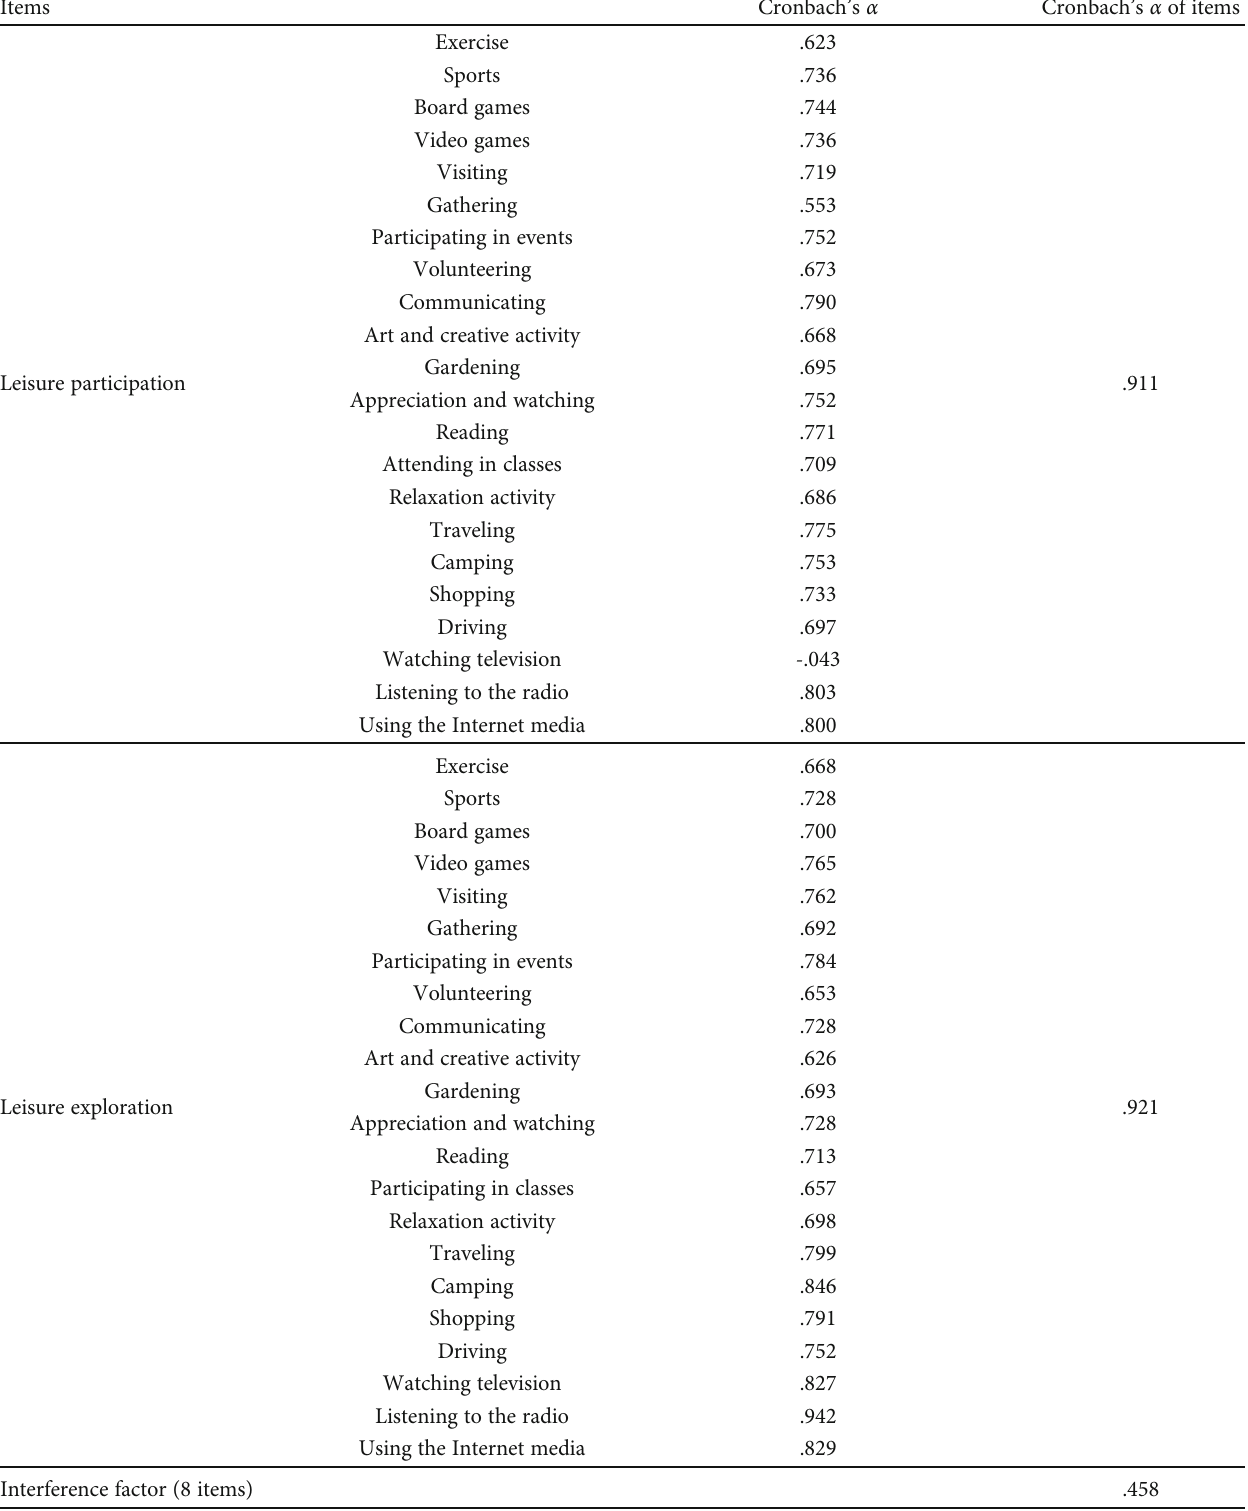
Table 4: The result of internal consistency ( N = 100 Þ